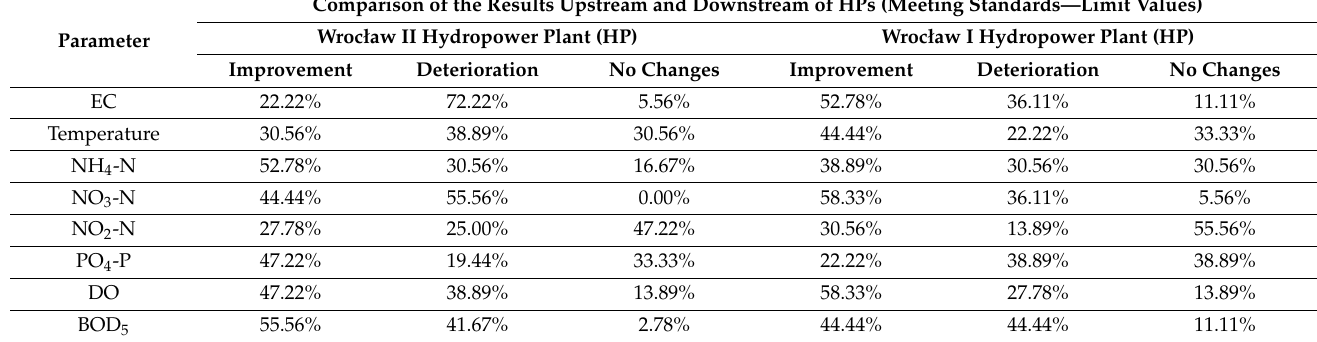
Table 10. Detailed summary of the results of the meeting standards against parameter limit values within the Wrocław I and Wrocław II hydropower plants.